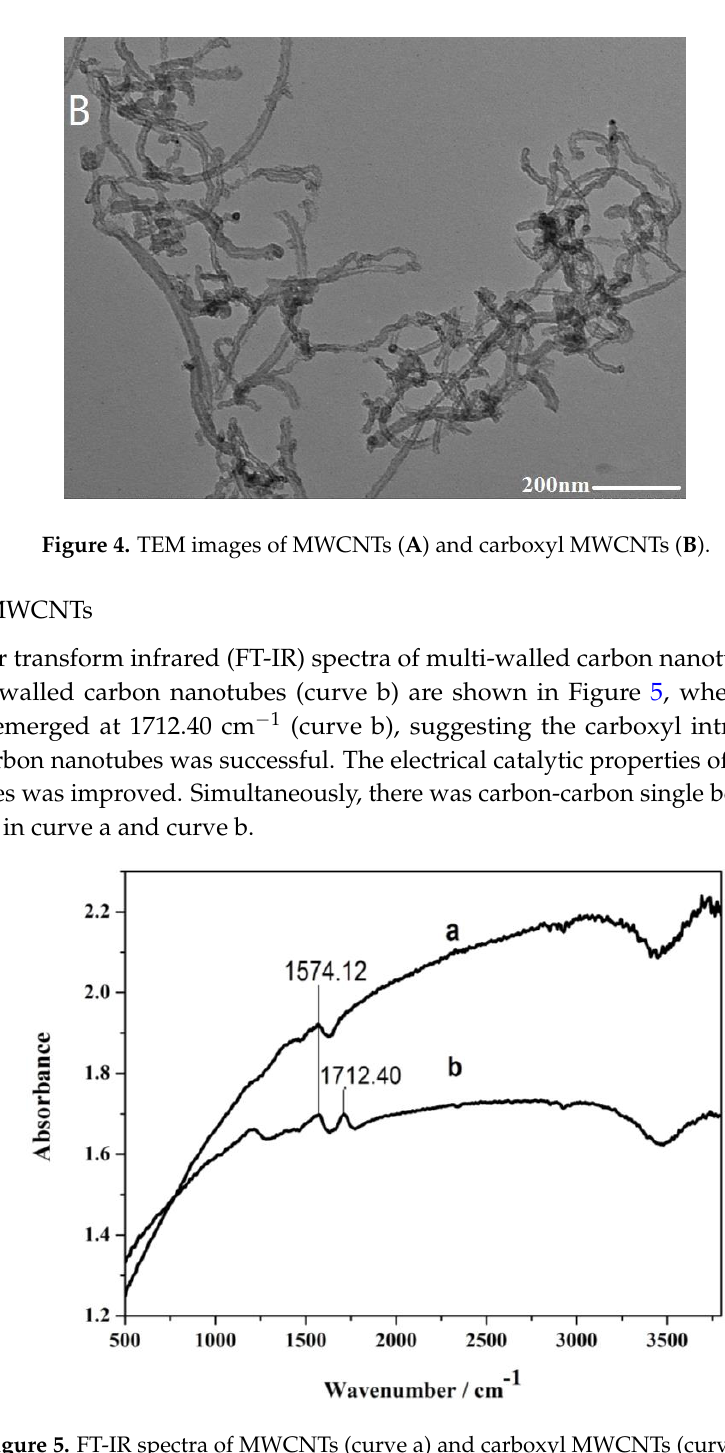
Figure 5. FT-IR spectra of MWCNTs (curve a) and carboxyl MWCNTs (curve b).